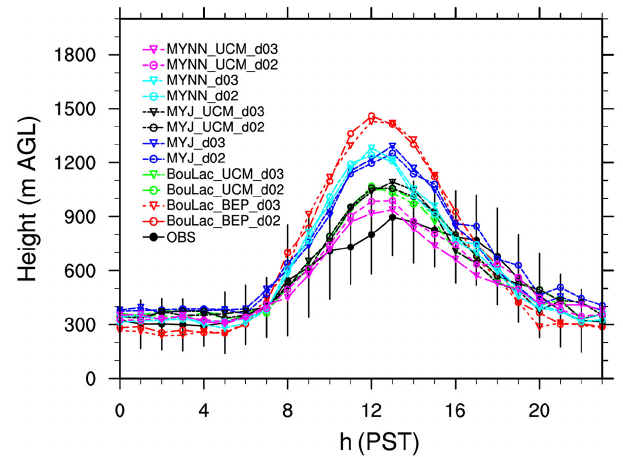
Figure 4. Average diurnal variation of the ceilometer-measured and modelled PBL heights at California Institute of Technology (Cal- tech) in Pasadena, CA, during 15 May through 15 June 2010. Er- ror bars indicate standard deviations of the means of the ceilometer measurement.